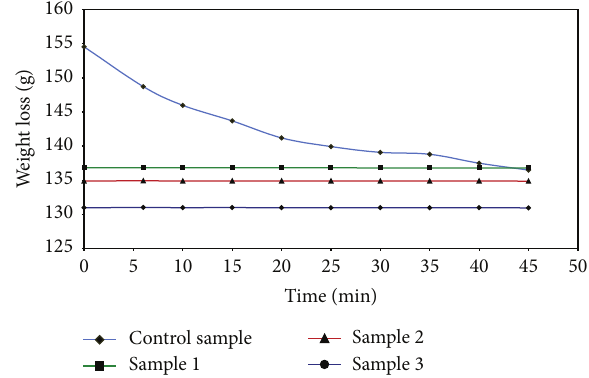
Figure 6: Weight loss versus time at 4m/s wind speed.